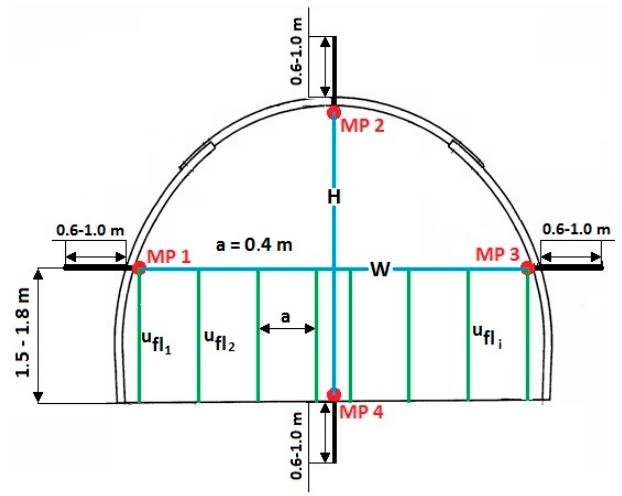
Figure 2. Scheme of convergence measurement station and the measurement methodology in D-2 Maingate.